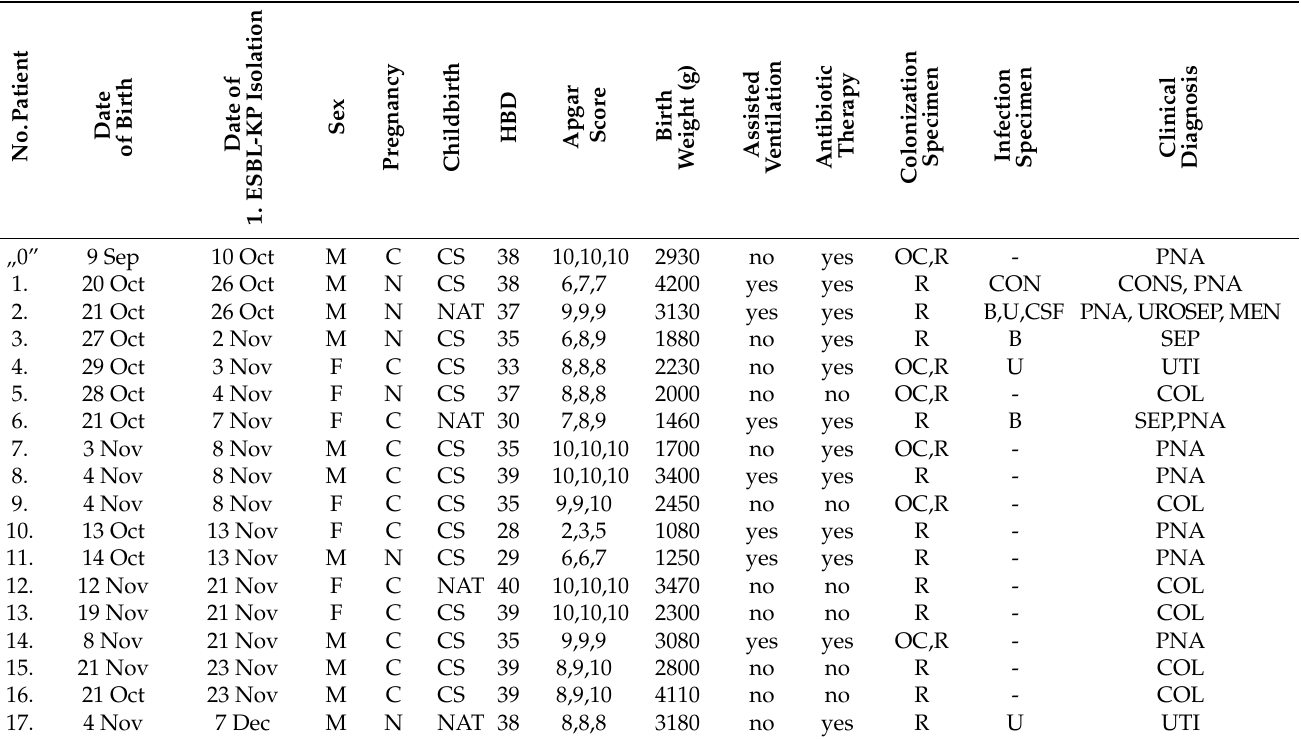
Table 1. Characteristic of neonates with laboratory-confirmed extended-spectrum β